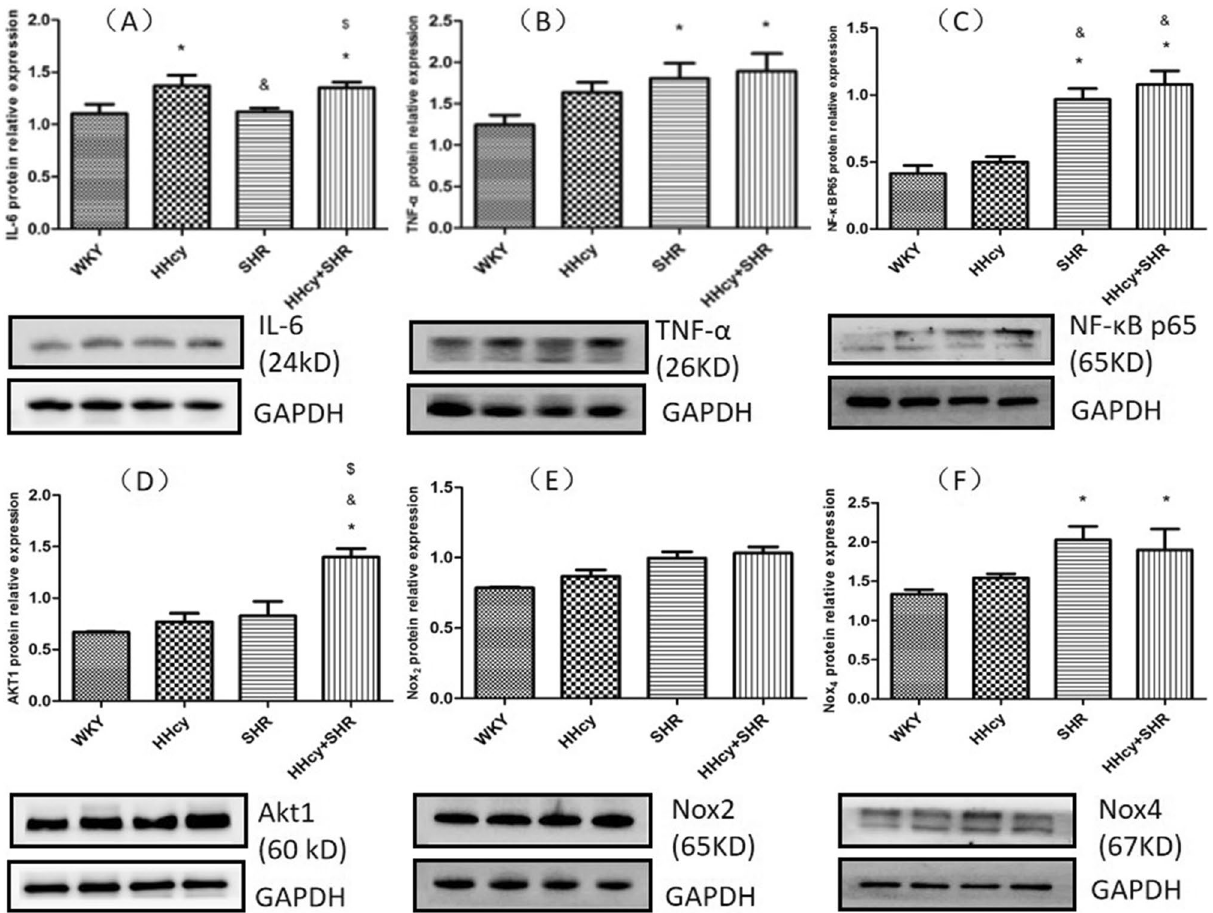
Figure 6. Representative images of target proteins and western blot analysis after normalized to GAPDH (35KD) in rat aortic tissue in Wistar-Kyoto (WKY) group, hyperhomocysteinemia (HHcy) group, spontaneously hypertensive rat (SHR) group and HHcy + SHR group. ( A ) interleukin-6 (IL-6, 24KD). ( B ) tumor necrosis factor-alpha (TNF-α, 26KD). ( C ) nuclear factor-κ-gene binding p65 (NF-κB p65, 65KD). ( D ) protein kinase B (Akt1, 60KD). ( E ) nicotinamide adenine dinucleotide phosphate oxidase 2 (Nox2, 65KD). ( F ) Nox4 (67KD). Values represent means ± SD ( * P < 0.05 vs. WKY group, $ P < 0.05 vs. SHR group, δ P < 0.05 vs. HHcy group, n = 8). The representative blots were cut prior to hybridization with antibodies during